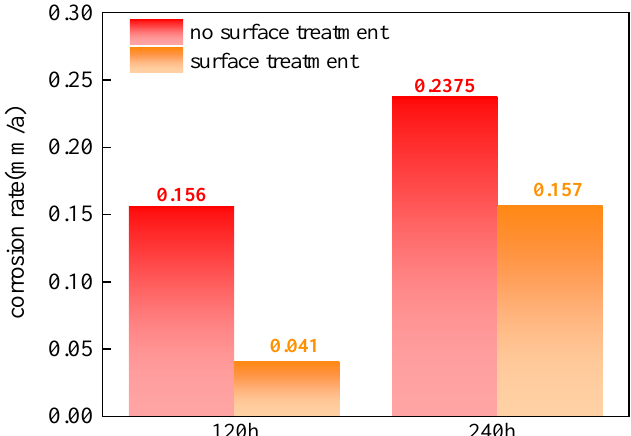
Figure 10. Corrosion rates of different ductile iron samples after different periods of immersion.